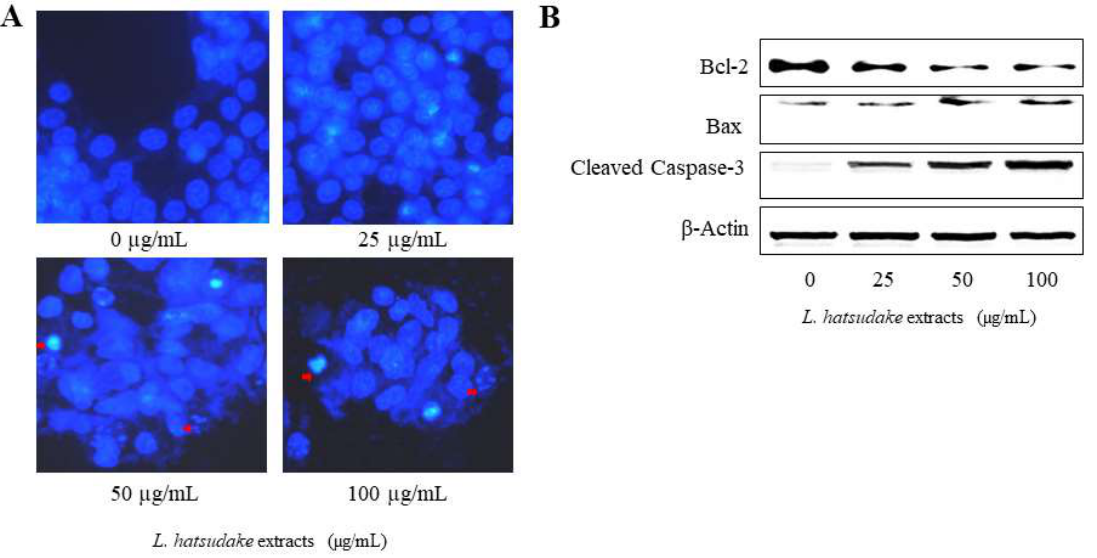
Figure 6. L. hatsudake extracts promoted HCT116 cell apoptosis and its molecular mechanism. ( A ) L. hatsudake extracts induced the apoptosis by Hoechst33258 fluorescent staining; ( B ) L. hatsudake extracts regulated apoptosis-related gene expressions by Western blotting in HCT116 cells.